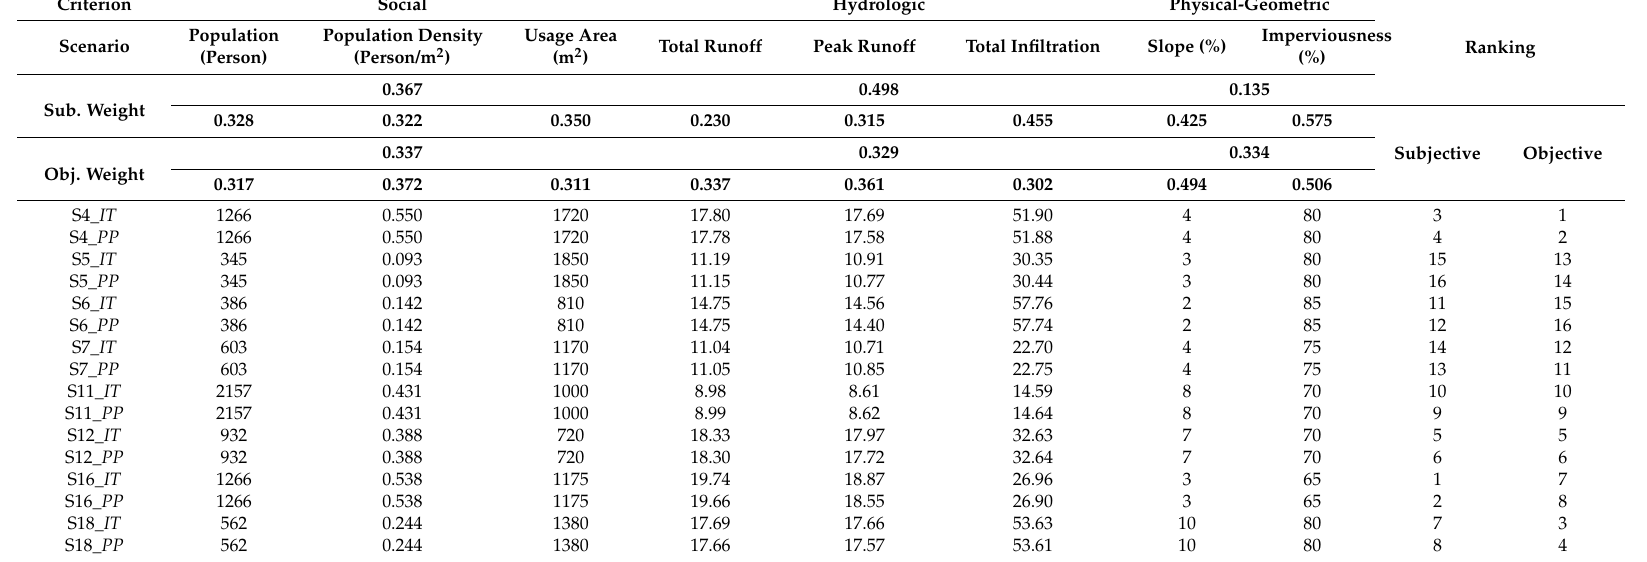
Table 7. Data used and derived final ranks for the best LID planning using TOPSIS considering social, hydrologic, physical-geometric factors. Criterion Social